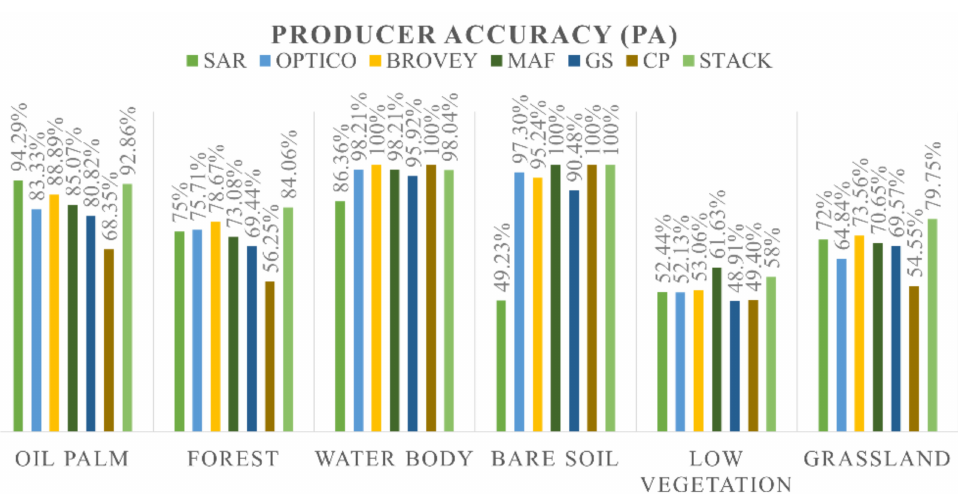
Figure 7. User accuracies obtained for each land cover.